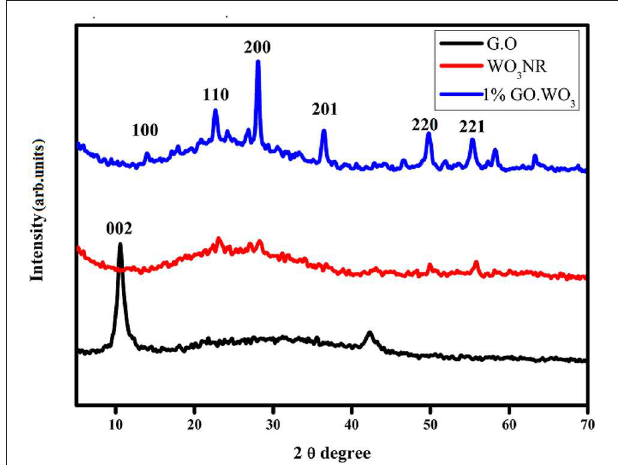
FIGURE 1 | XRD patterns of GO, WO 3 , 1%GO.WO 3